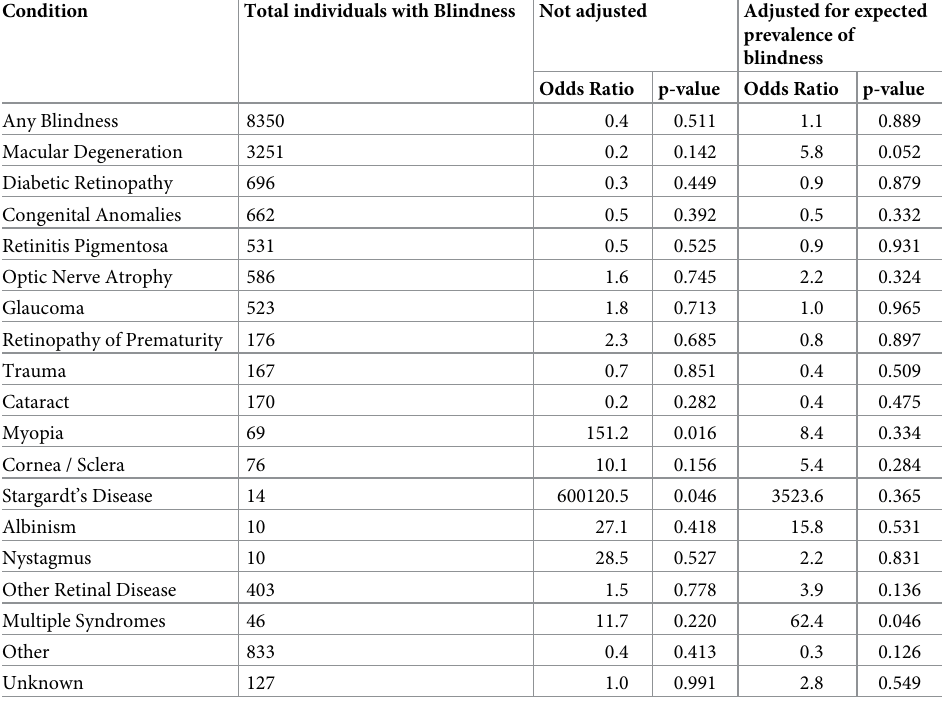
The number of persons with blindness due to various causes, and odds ratios for the change in prevalence of blindness (per 1000 persons in the county) associated with one more optometrist per 1000 persons. The first model shows univariate odds ratios; the second model shows the odds ratio after adjusting for expected prevalence of blindness based on the multivariable model